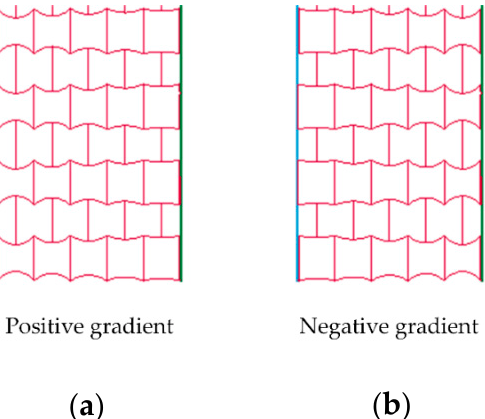
Figure 20. Section of sandwich panel with gradient honeycomb. ( a ) Positive gradient; and ( b ) Negative gradient.